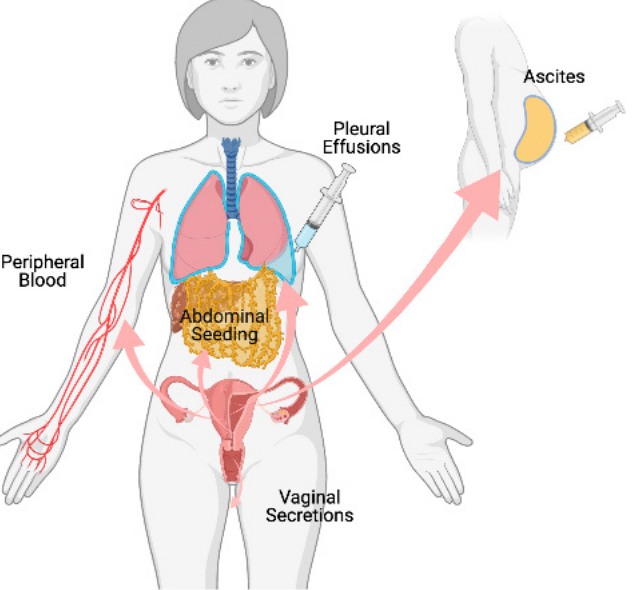
Figure 2. Gynecologic tumor-derived exosome spread in creating tumor microenvironments. Created with BioRender.com (accessed on 19 October 2021).